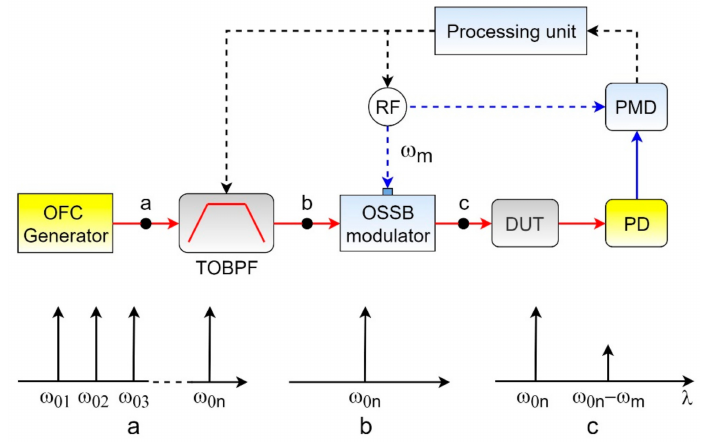
Figure 4. The schematic diagram of the OVA based on OSSB-modulation and optical frequency comb: OFC Generator—optical frequency comb generator; TOBPF—tunable optical bandpass filter; DUT—device under test; PD—photodetector; PMD—phase–magnitude detector; RF—radiofrequency; ω ω m —modulation frequency; red lines—optical signal; blue 0 —frequency of the optical carrier; lines—electrical signal; dotted line—data path (adapted from